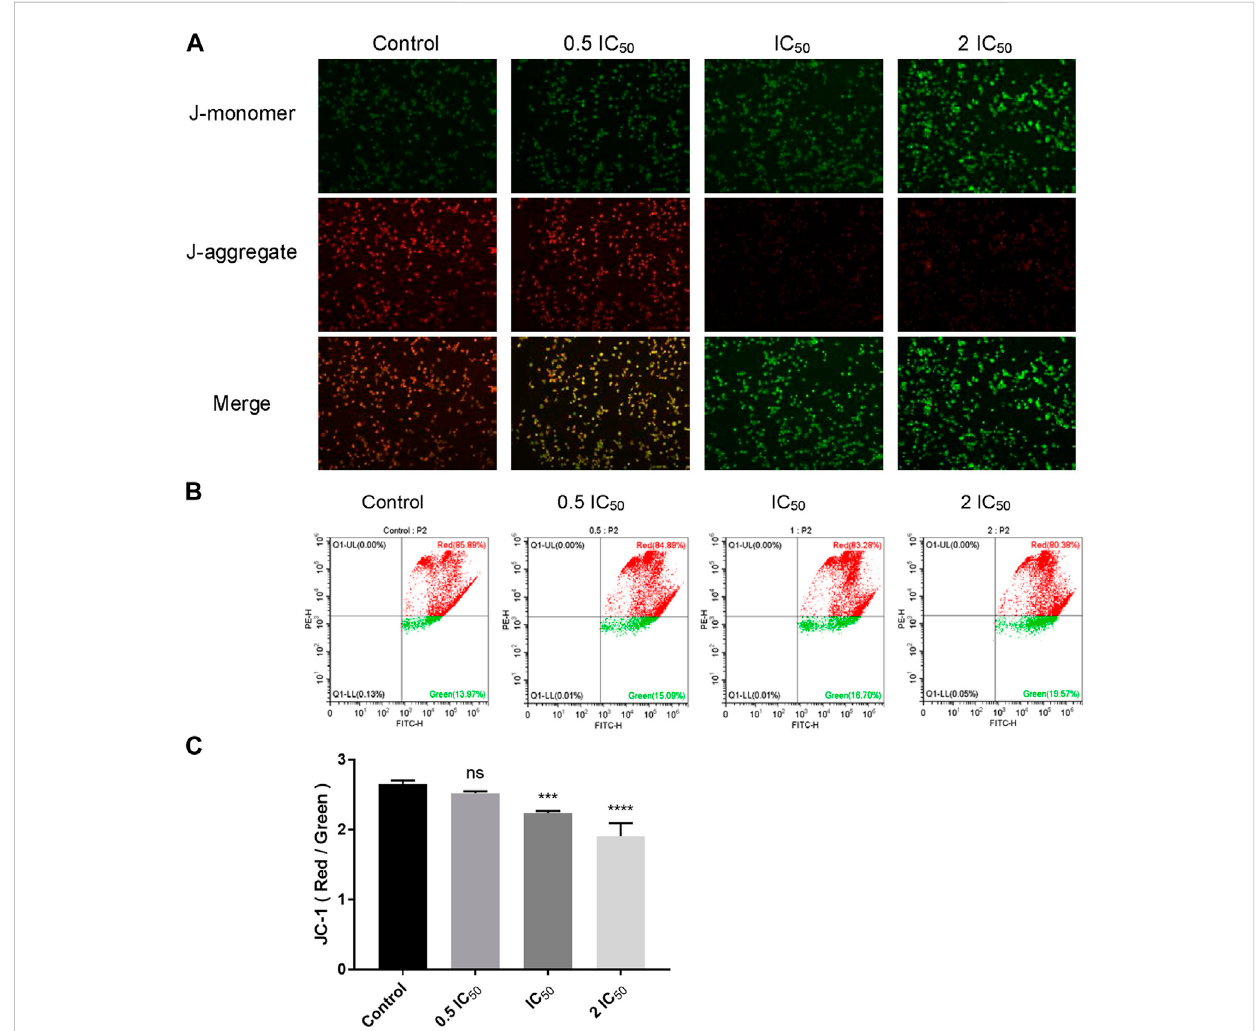
FIGURE 8 Compound 6e reduced MMP in KB cells. (A) Fluorescence images of KB cells treated with compound 6e . (B) The MMP of KB cells treated with compound 6e was determined by fl ow cytometry. (C) Quanti fi cation of the decreased MMP ( n = 3). **** ( p < 0.0001), *** ( p < 0.001), ** ( p < 0.01), * ( p < 0.05), ns (not signi fi